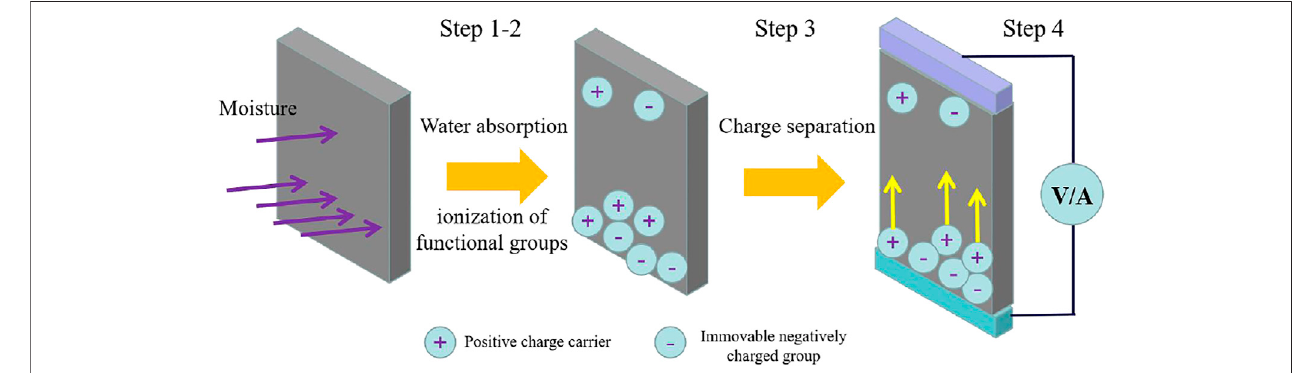
FIGURE 3 | Working mechanism of the MEG process.